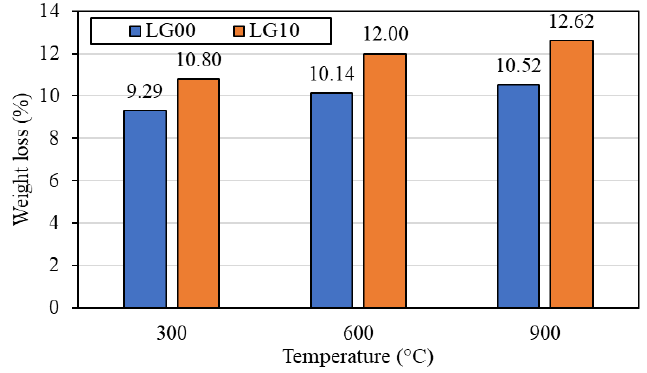
Figure 19. Weight loss of LG00 and LG10 after exposure to elevated temperatures.